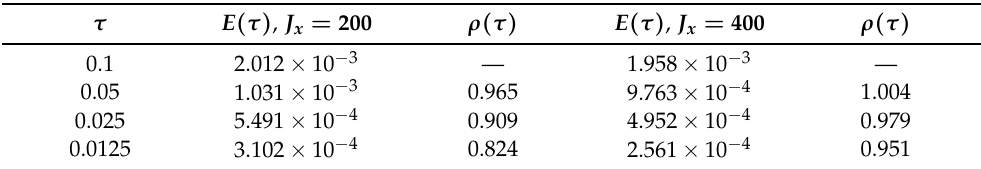
Table 1. Errors E ( τ ) and experimental convergence rates ρ ( τ ) for the discrete solution of the BE scheme (10) for a sequence of time steps τ .